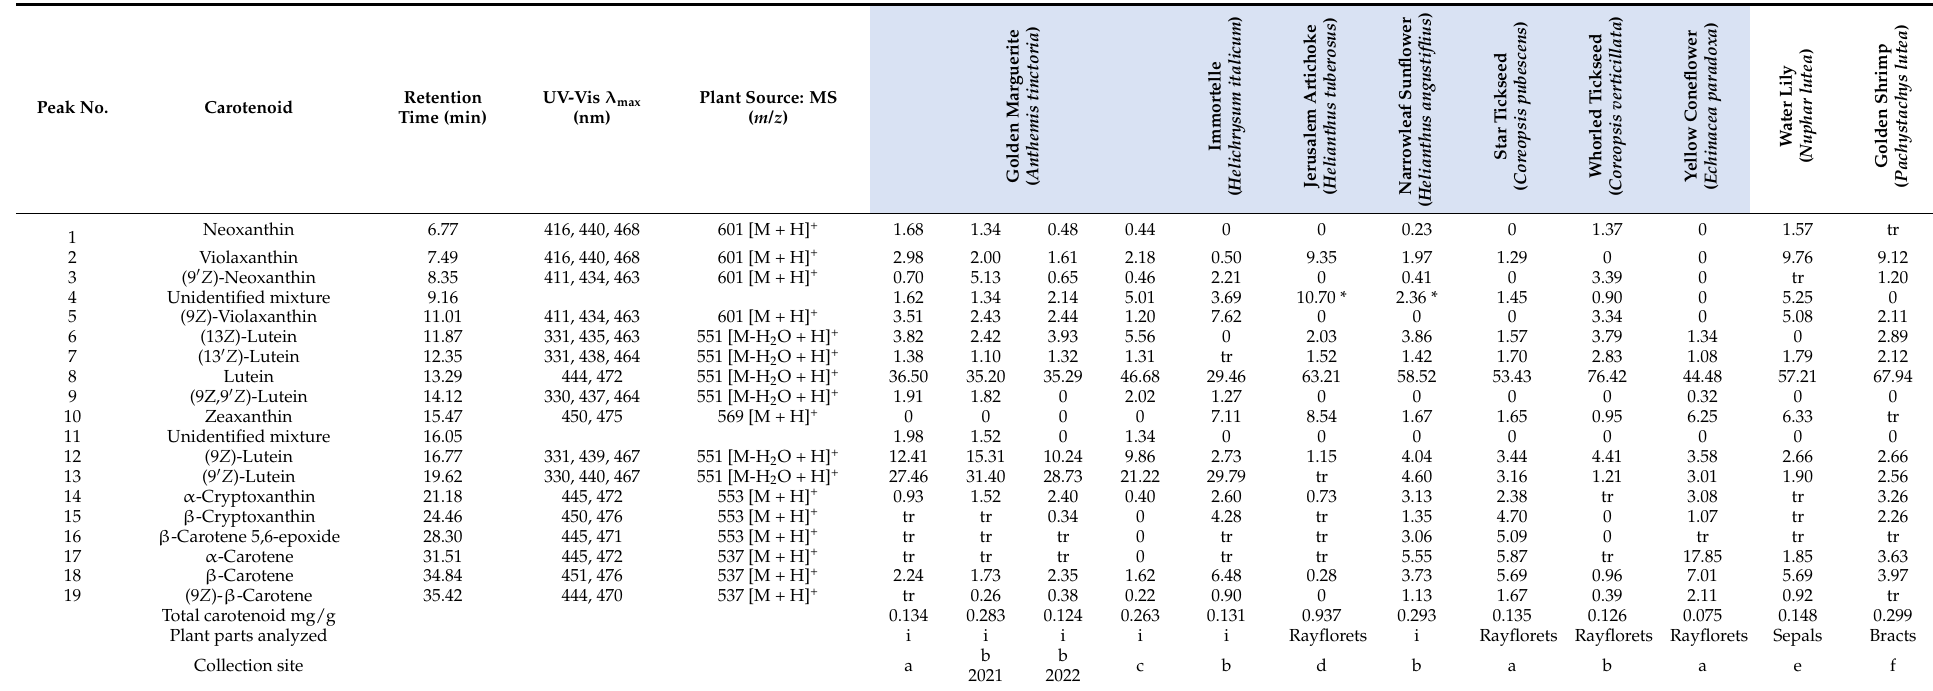
Table 2. Carotenoid composition of the investigated flowers via HPLC analysis. Color shades show the same family.